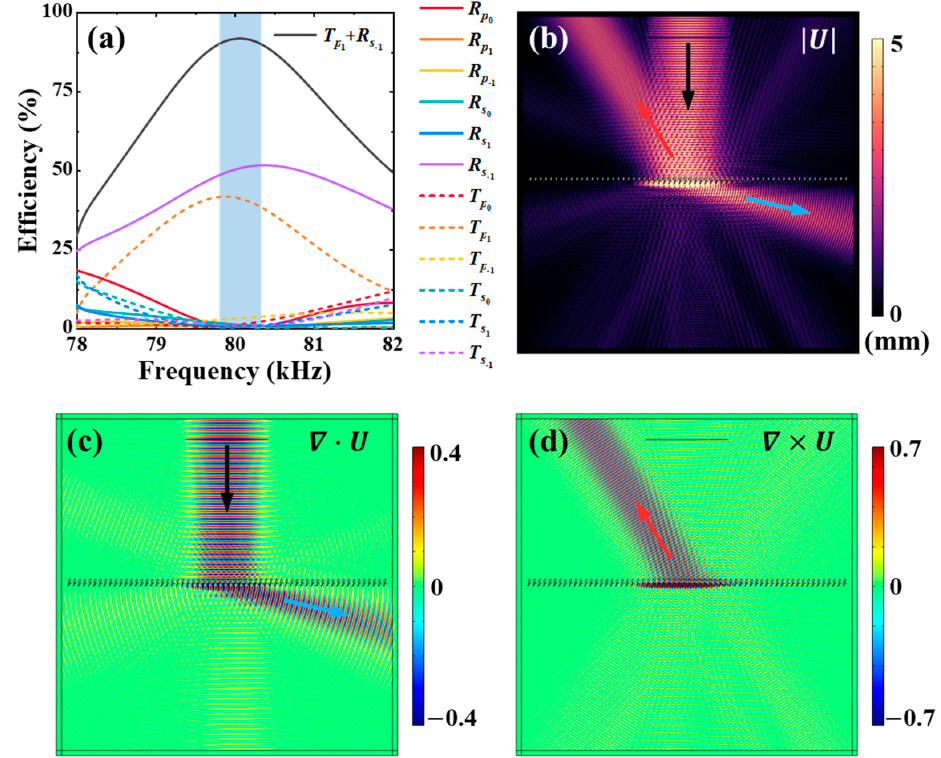
Figure 3. High-efficiency diffraction along the T p and R s channels when a p -wave is normally inci- dent on the metagrating. ( a ) The diffraction efficiency spectra for all 12 channels, where f 0 = 80 kHz is the operating frequency; ( b ) shows the amplitude of displacement amplitude at f 0 ; ( c , d ) show the divergence and curl of the displacement field, corresponding to longitudinal and transverse wave components, respectively. Black, blue, and red arrows represent the incident p -wave, transmitted p -wave, and reflected s -wave, respectively.